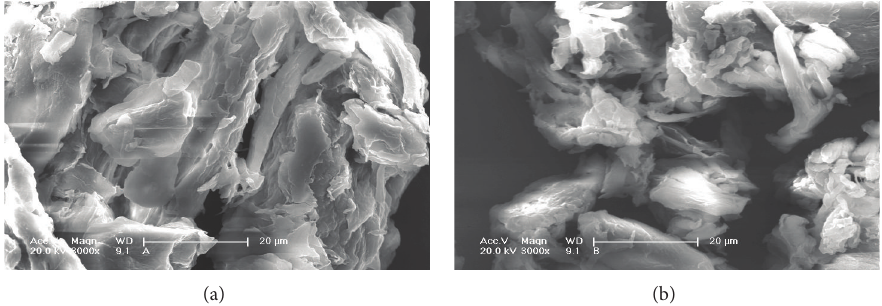
Figure 5: SEM micrographs ( × 5,000) of the cellulose powders with chemical treatment. (a) Untreated cellulose powders. (b) Dispersed cellulose powders with